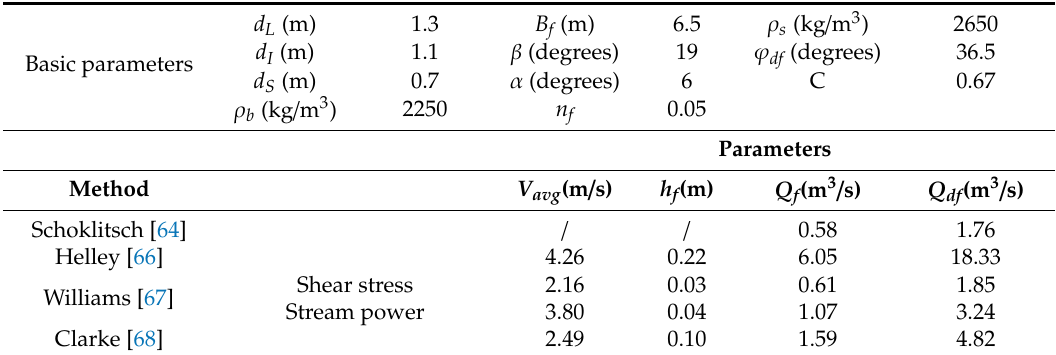
Table 3. Summary of the calculation results based on the maximum boulder size methods.